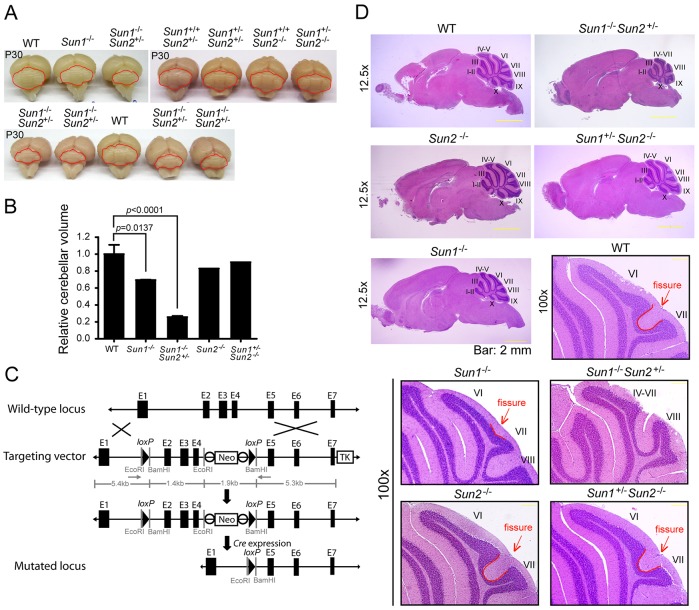
Sun1−/− mice show aberrant cerebellar development. (A) Pictures of mouse brains from 30-day-old mice with the indicated genotypes. The mouse cerebellums are outlined in red. (B) Statistics of relative cerebellum volume of the brains shown in A, calculated by using width×length2. The volume of cerebellums from Sun1−/− (P=0.0137) and Sun1−/−Sun2+/− (P<0.0001) mice is significantly reduced compared to that of WT. Student's t-test. (C) Generation of Sun2-knockout mice. The WT allele, the targeting vector and the mutated locus of Sun2 are presented in the scheme. The targeting vector contains the PGK-Neo gene (Neo) and the thymidine kinase gene (TK). The solid triangles represent loxP sites, and white circles are FRT sites. (D) H&E-stained sagittal sections of paraffin-embedded mouse brains from 30-day-old WT, Sun1−/−, Sun1−/−Sun2+/−, Sun2−/− and Sun1+/−Sun2−/− mice. Image magnifications (12.5× and 100×) are indicated. Numerals indicate the lobules, and the fissures between lobule VI and VII of cerebellums are outlined in red lines and indicated by red arrows. Scale bars: 2 mm (200 μm in magnification images).